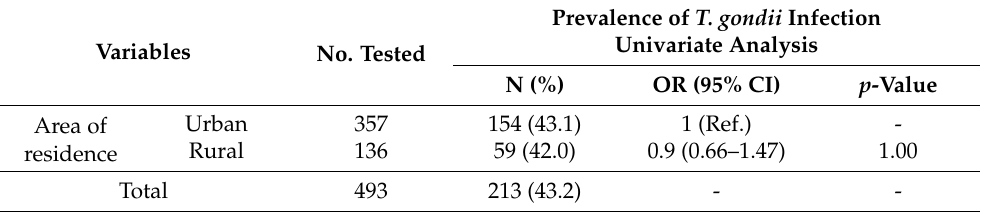
Table 2. Seroprevalence of Toxoplasma gondii infection in female blood donors from Western Romania aged 18–45 years, according to area of residence.